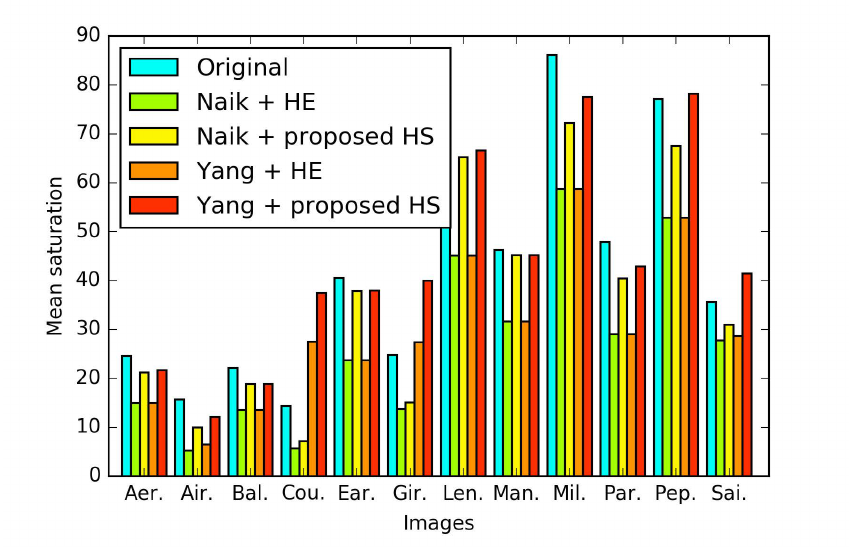
Figure 6. Mean saturation.